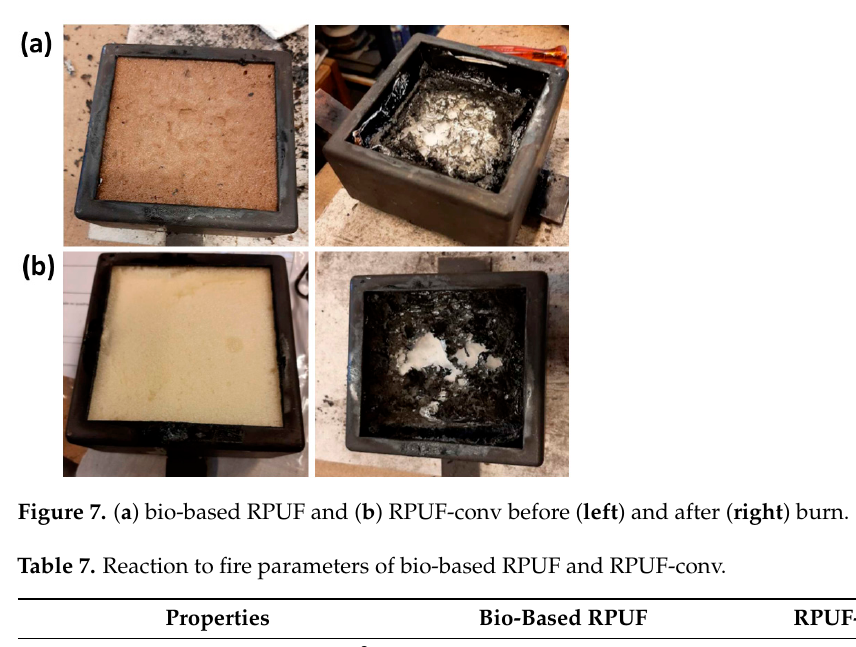
Table 7. Reaction to fire parameters of bio-based RPUF and RPUF − conv.